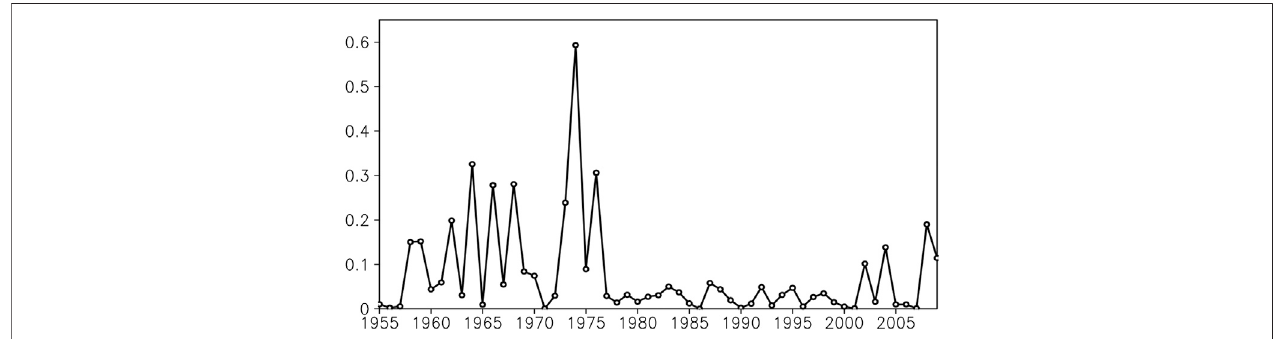
FIGURE6 | Evolution of theconvergence index ofthe simulatedspatial distribution ofYangtze Meiyu by thethree cumulusparameterization schemes. The smaller the index, the stronger the convergence.